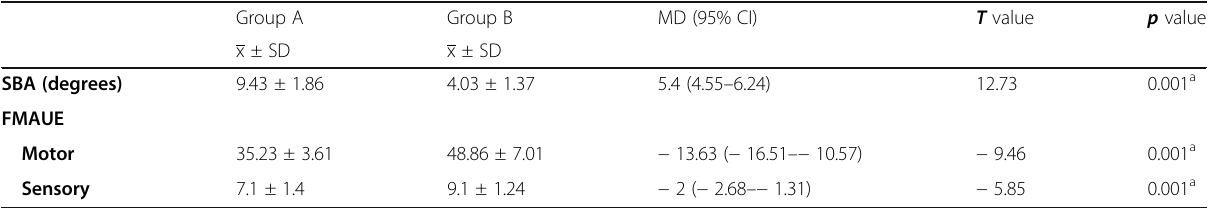
Table 3 Comparison of SBA and FMAUE between groups A and B Group